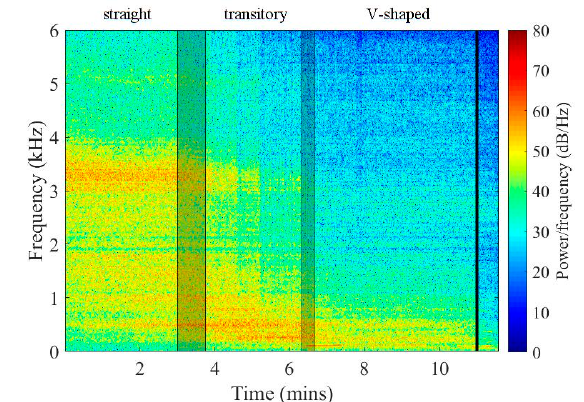
Figure 4. Spectrogram of a single measurement at p g = 0.8 bar, using a 15° quarl. The shaded areas indicate the changeover between two points with distinct flame characteristics. Blowout is indicated by the vertical black line, beyond which the spectrum of the cold flow noise is visible.